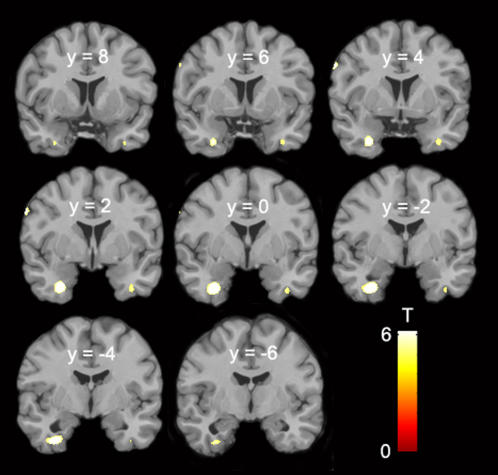
Areas of increased GM concentration in heterosexual women compared to homosexual women.Coronal sections from y = 8 to y = −6 (p<0.05; FDR corrected). Left brain side is to the left.